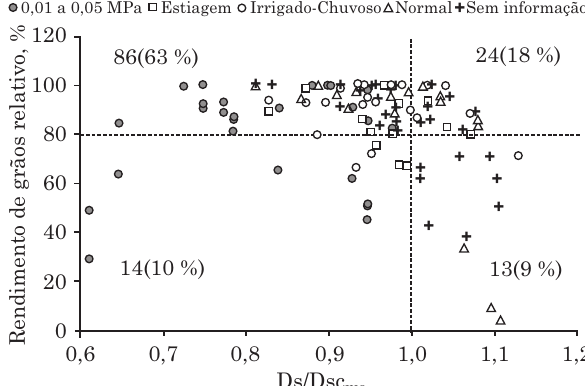
Figura 2. Relação do rendimento relativo com a razão Ds/Dsc IHO . Os dados foram compilados dos trabalhos de Beutler et al. (2004a,b, 2005, 2007); Secco et al. (2004, 2009); Camara & Klein (2005b); Collares et al. (2006); Lima et al. (2006); Marcolan & Anghinoni (2006); Freddi et al. (2007); Gubiani (2008); Klein et al. (2008); Nicoloso et al. (2008); Collares et al. (2008); Amado et al. (2009); e Kaiser (2010). Ao total, são 141 dados de produção de grãos das culturas de arroz, trigo, soja, milho e feijão, densidade do solo e teor de argila. As informações da legenda representam subgrupos conforme indicadores de regime hídrico descrito pelos autores. O rendimento relativo foi calculado dentro de cada grupo de comparação previamente definido nos experimentos. Foi usada a Ds até a camada de 0,3 m, onde se verificava maior diferença entre os manejos de